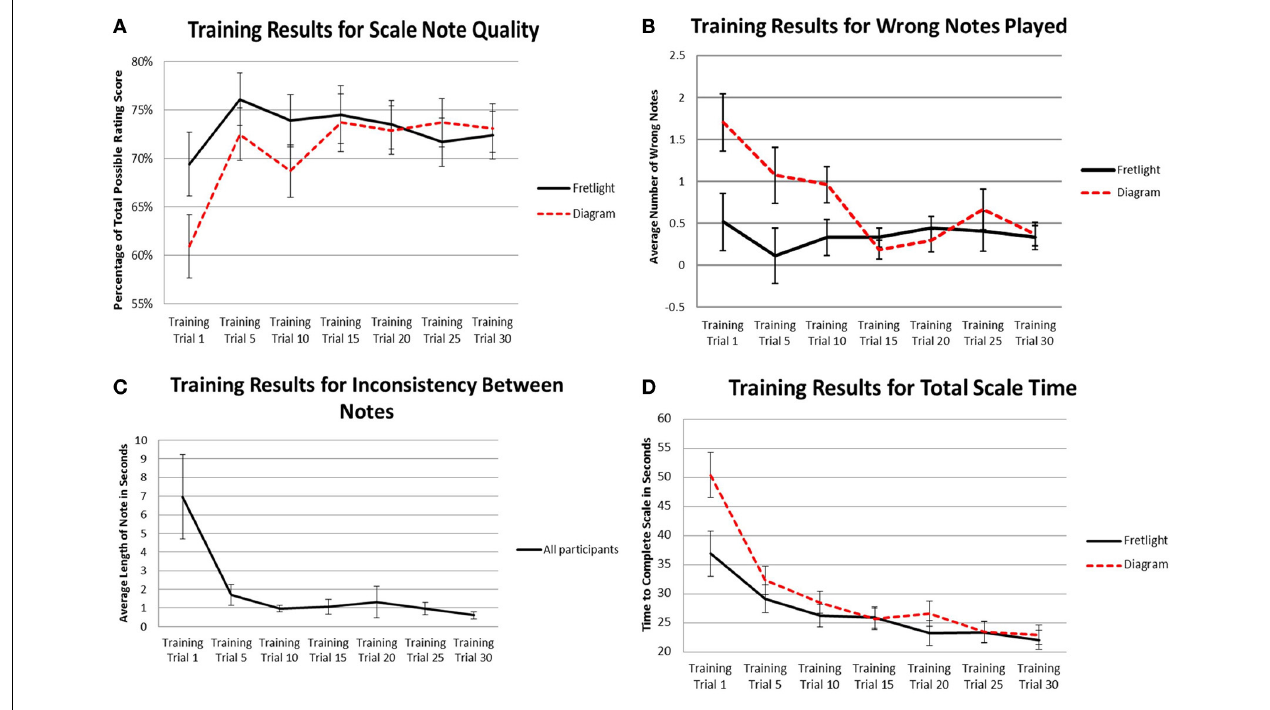
FIGURE 4 | (A) Interaction effect of time practicing and learning method on scale note quality; (B) Interaction effect of time practicing and learning method on wrong notes played; (C) Main